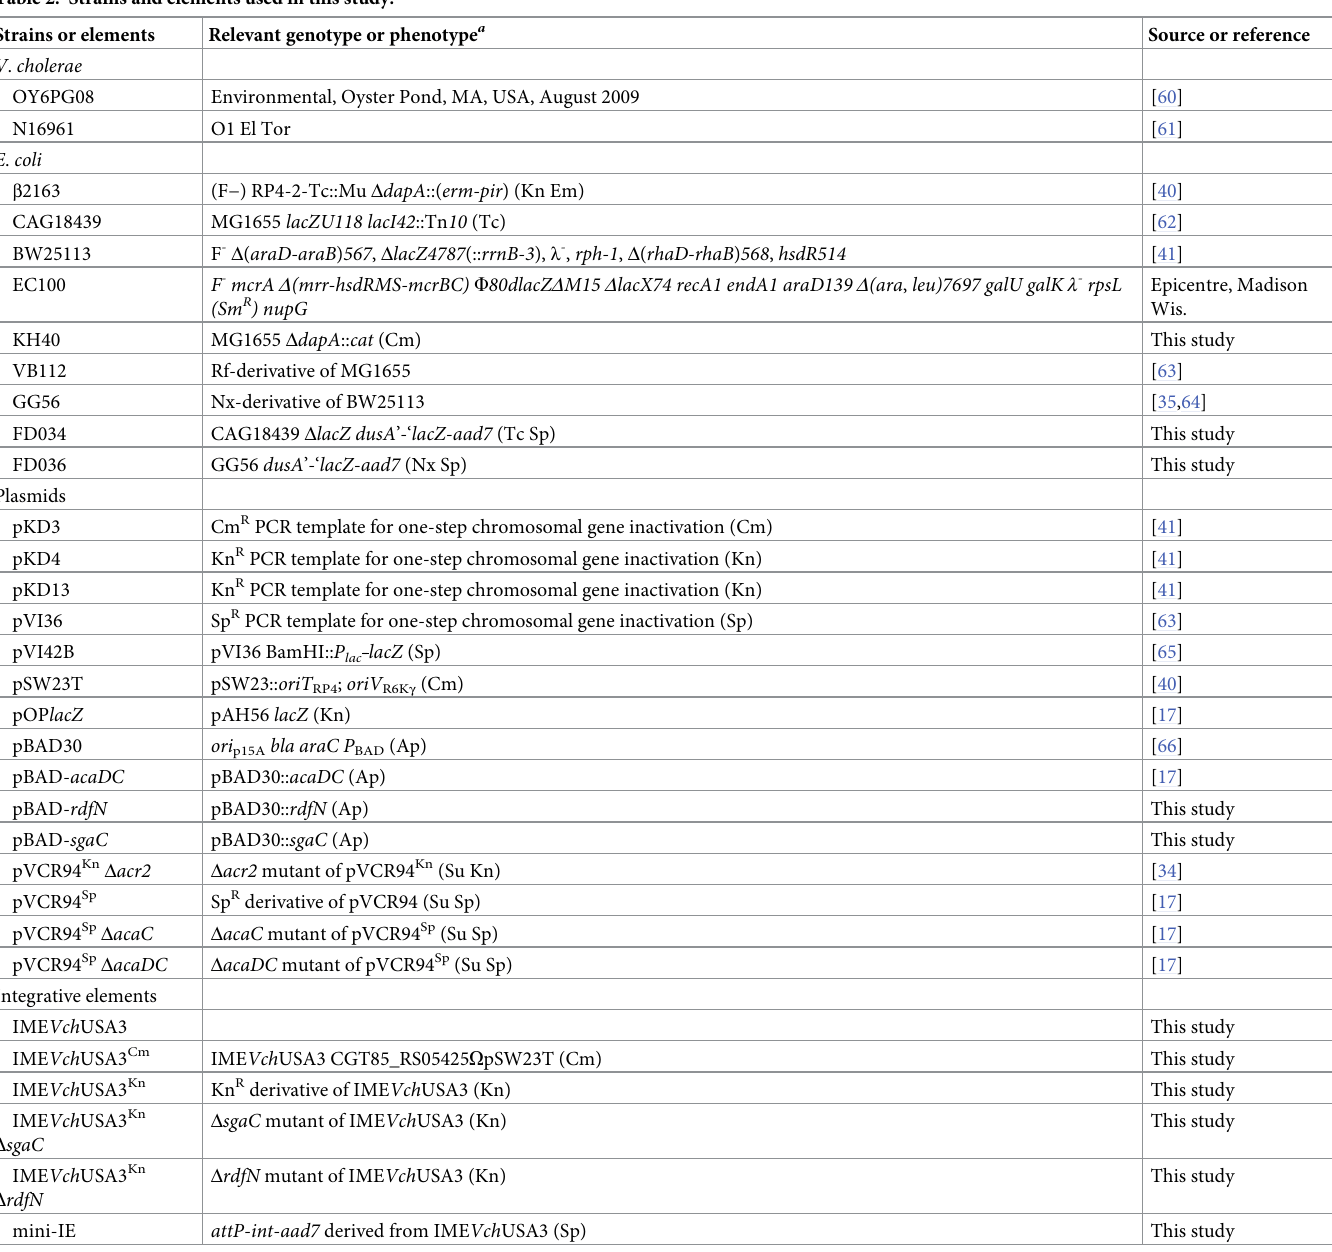
Table 2. Strains and elements used in this